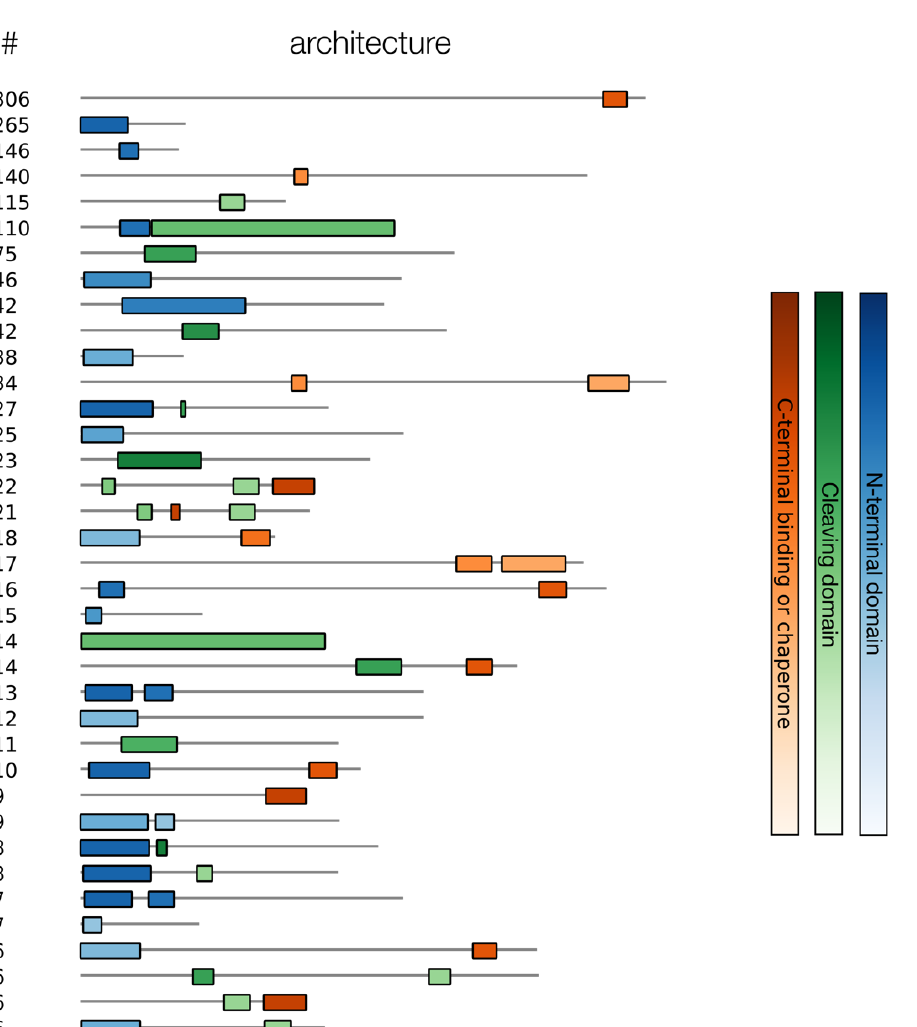
Figure 4. Architectures of the RBPs detected with RBP-related HMMs from the Pfam database, together with their number of occurrences and divided into three categories (N-terminal domains, cleaving domains, and C-terminal binding domain or chaperone). Examples of N-terminal domains are Phage_T7_tail and Tail_spike_N . Examples of cleaving domains are Lipase_GDSL_2 and Pectate_lyase_3 . Examples of binding domains and chaperones are Phage_fiber_C and CBM_4_9 . Only the architectures that occurred more than five times were visualized. The top-five occurring architectures are single-domain architectures, indicating that there are many unknown RBP-related protein domains in the Pfam database.